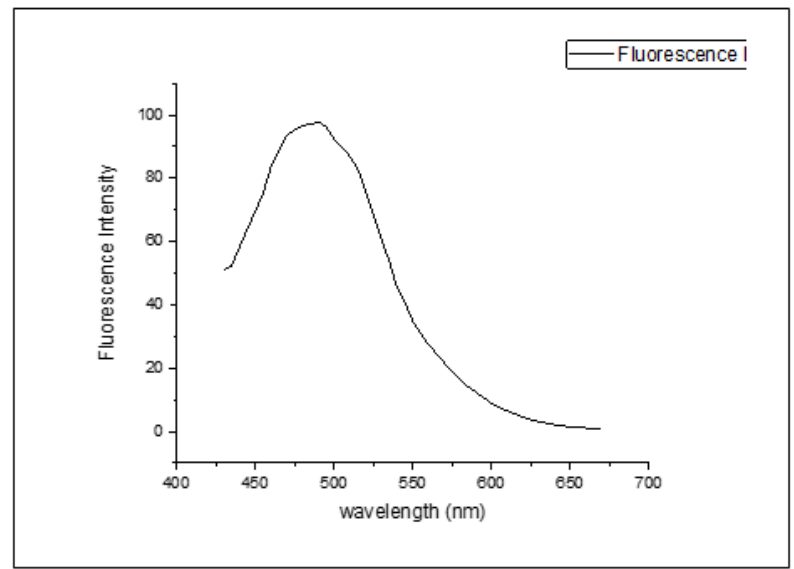
Fig. 21. Fluorescence of PG polyester